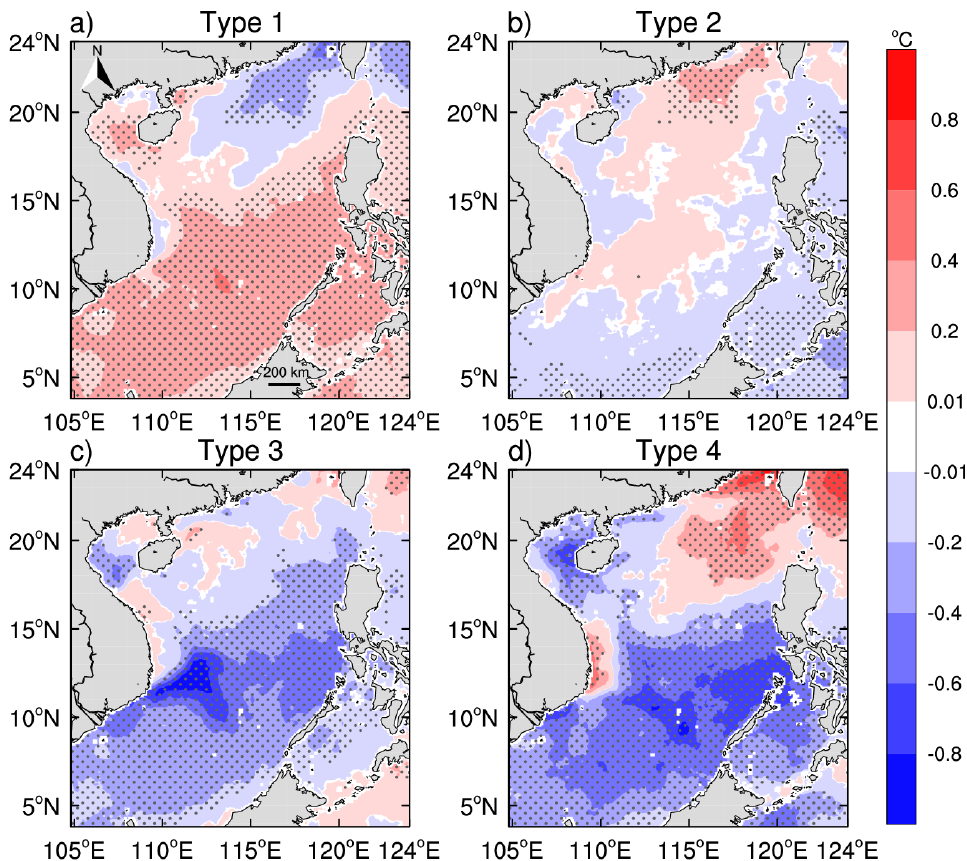
Figure 3. Chl-a concentration anomaly under the four synoptic types (the gray dots cover areas with significant differences): ( a ) Type 1; ( b ) Type 2; ( c ) Type 3; ( d ) Type 4.